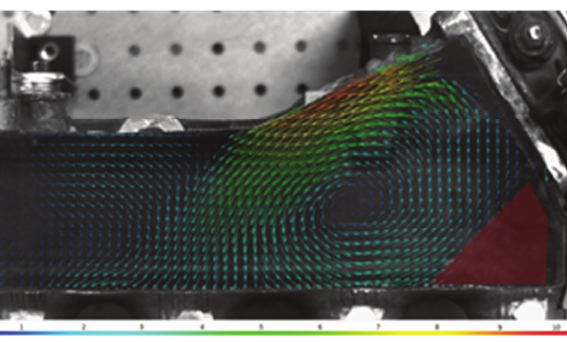
Fig. 12. Velocity vector distribution and air flow direction in the intake manifold at 1500 RPM engine speed and 30˚ throttle position angle